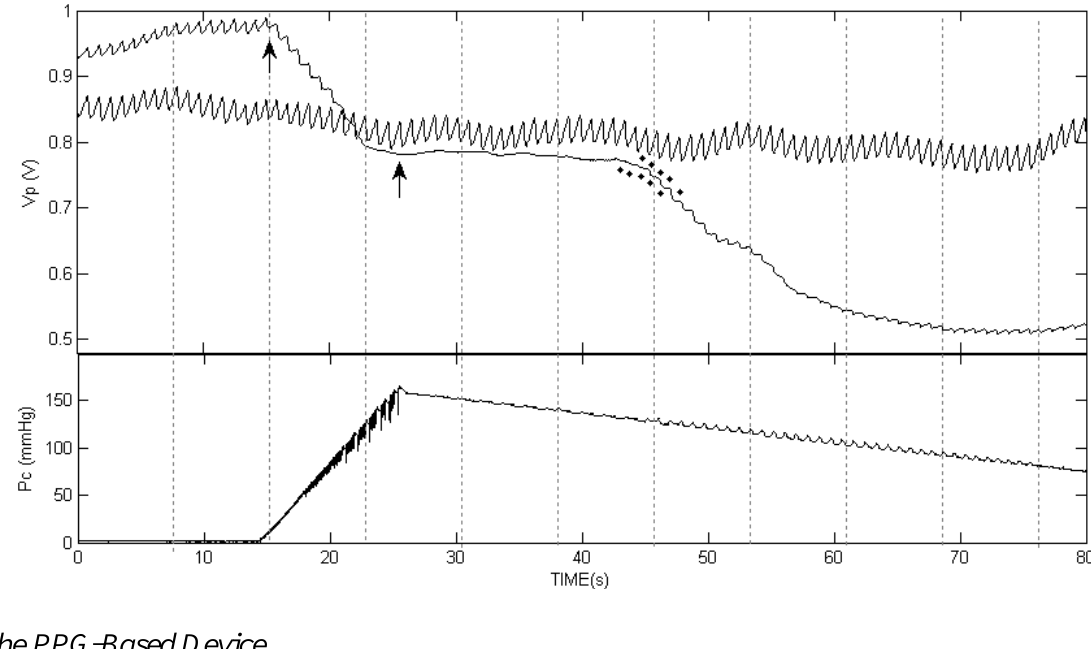
Figure 1. The PPG signals (V ) in the two hands of one of the subjects (above) and the P ) as a function of time (below), during cuff inflation to above the SBP cuff pressure (P c value and subsequent slow cuff deflation. The PPG pulses distal to the cuff disappeared when the cuff pressure increased to above the SBP value and reappeared when the cuff pressure decreased below the SBP value. The arrows indicate the start and stop of the cuff inflation. The stars above and below the PPG curve indicate the detection of the first Korotkoff sounds by the two